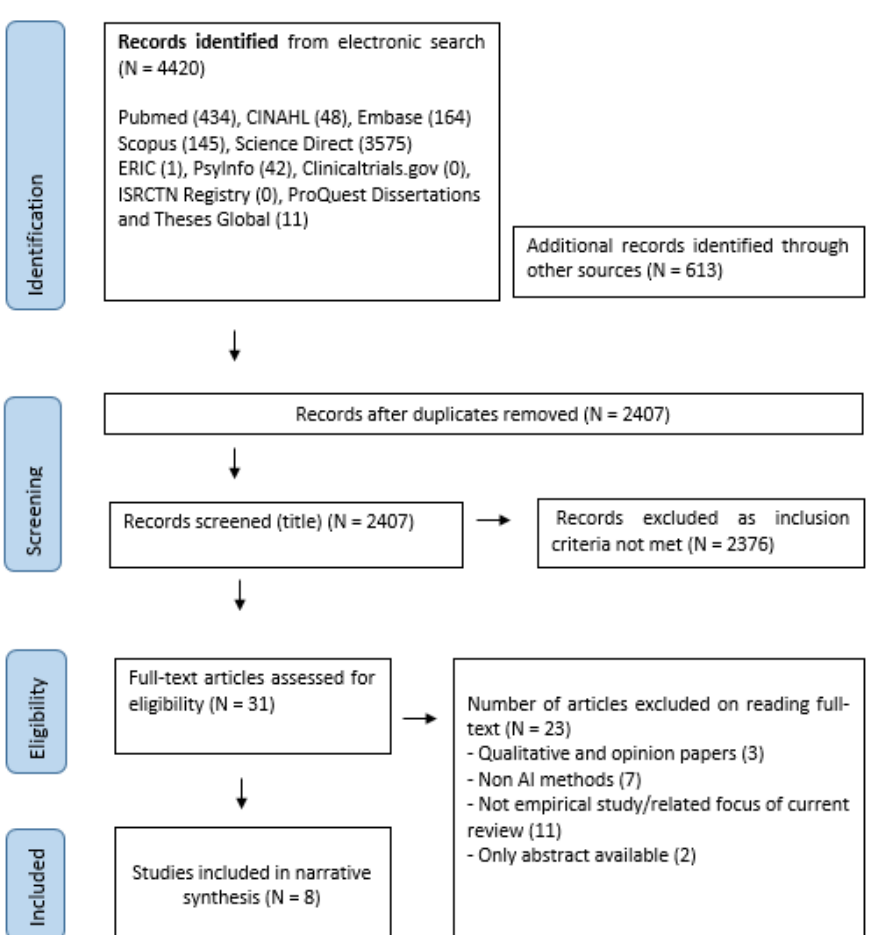
Figure 1. Prisma chart showing search process and final number of papers included in the review.